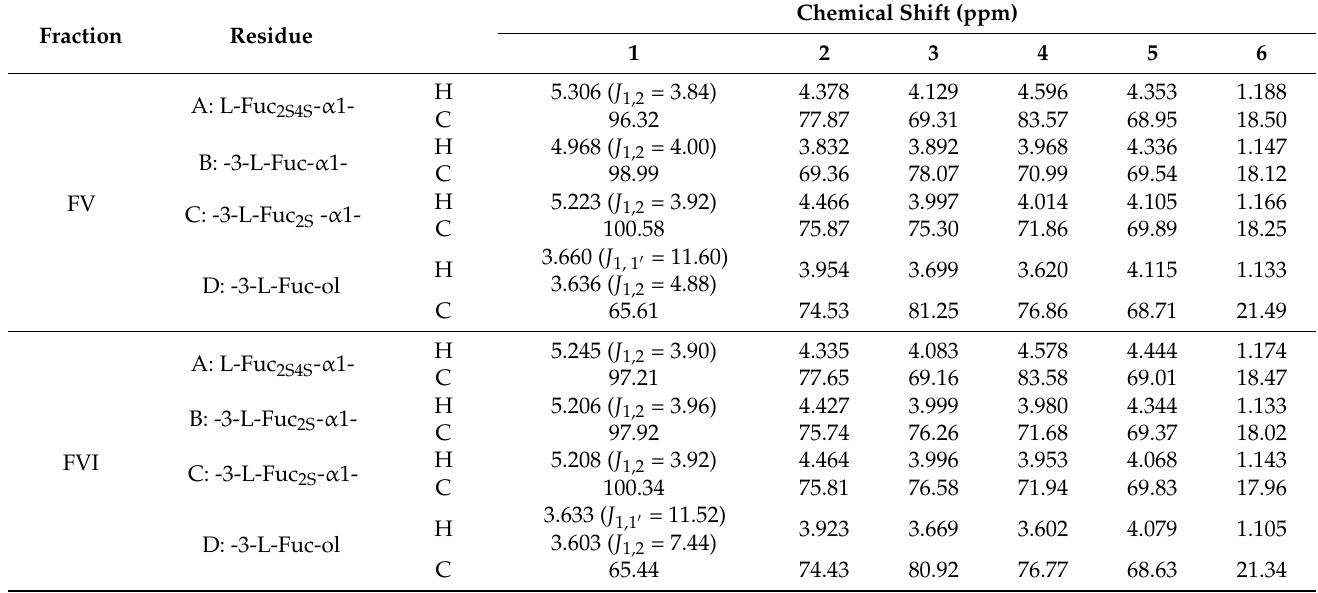
Table 3. 1 H and 13 C chemical shifts of the oligosaccharide FV and